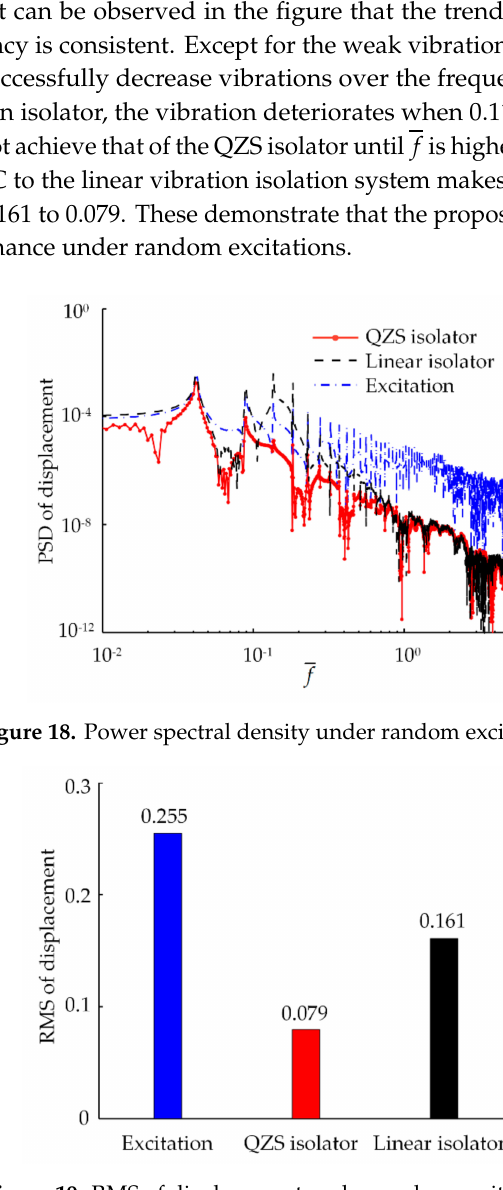
Figure 19. RMS of displacement under random